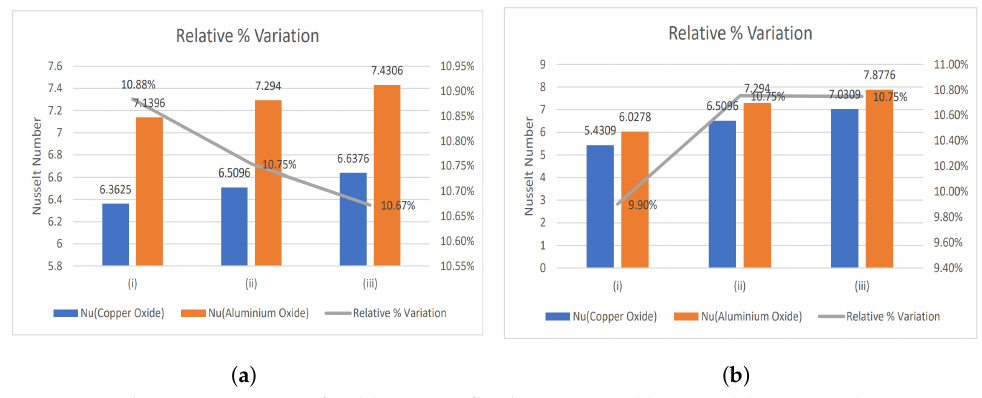
Figure 5. Relative % variation for ( a ) Casson fluid parameter (i) β = 1, (ii) β = 2, (iii) β = 10, and ( b ) Prandtl number (i) Pr = 14, (ii) Pr = 21, (iii) Pr =